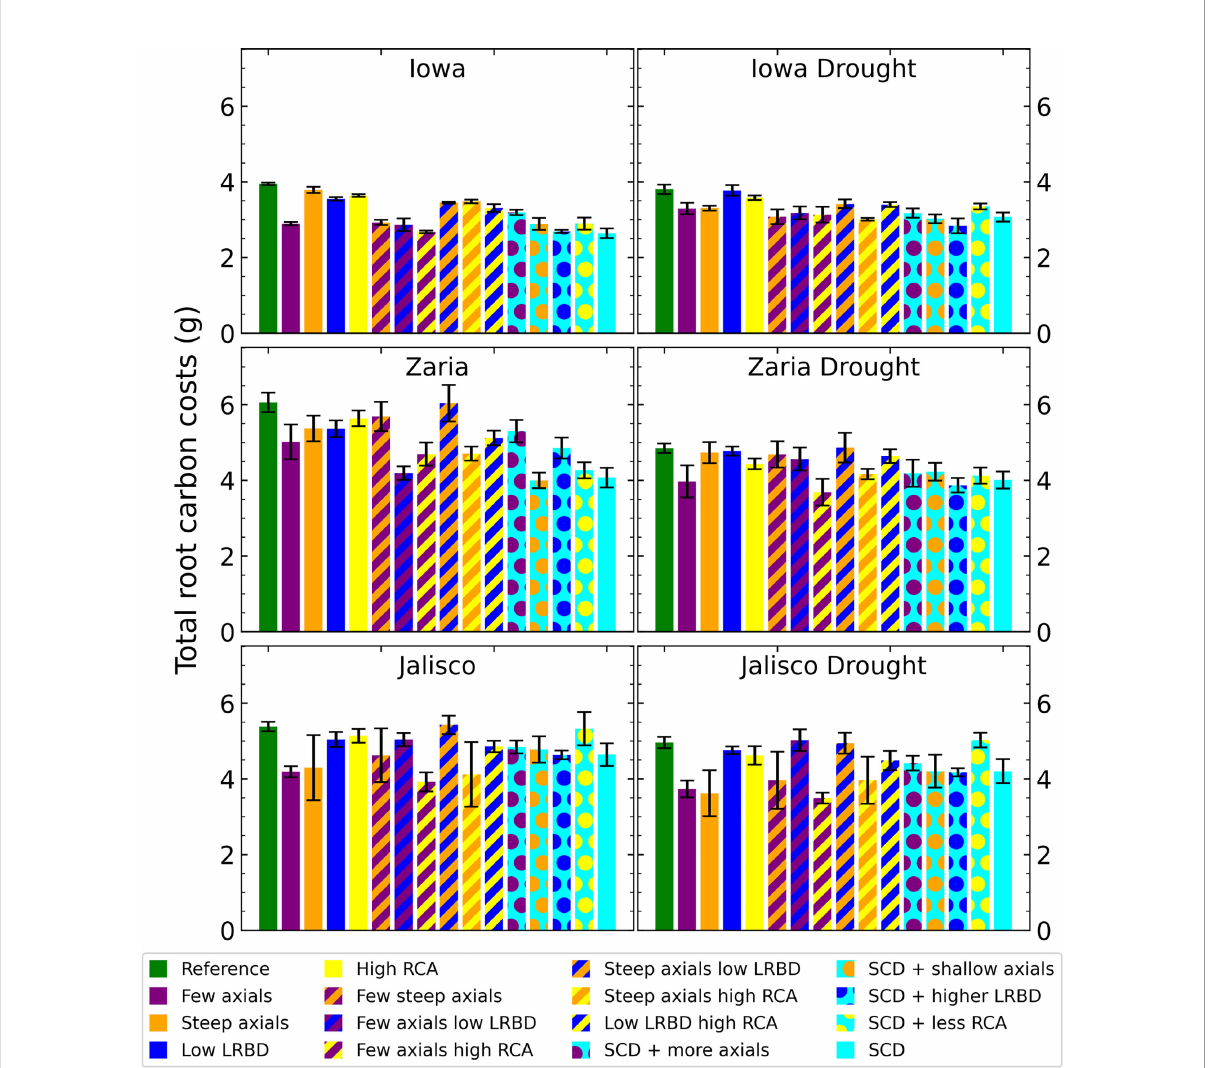
FIGURE 4 Total carbon invested in roots (biomass, exudation and respiration) of all the maize phenotypes considered after 42 days in the 6 different environments. The error bars indicate standard deviation, n (replicates) = 5. LRBD means lateral root branching density, RCA means root cortical aerenchyma and SCD refers to the steep, cheap, deep